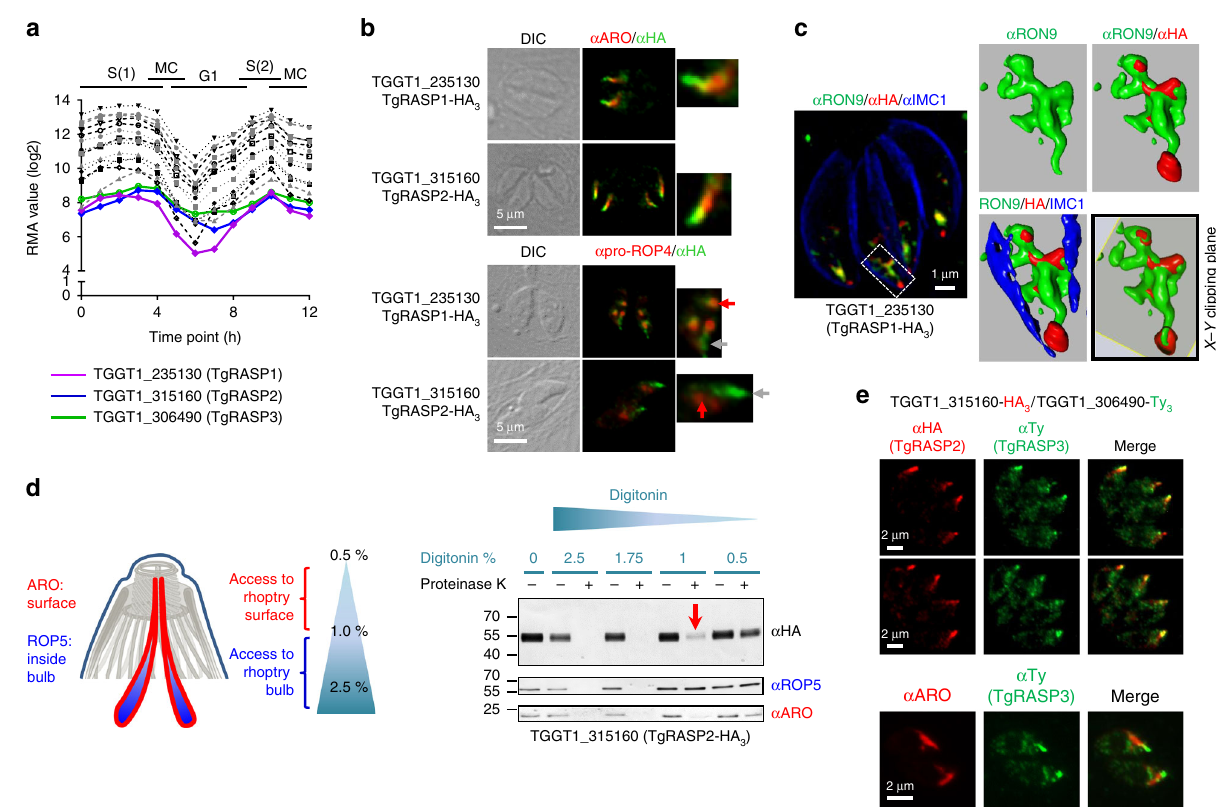
Fig. 1 A subset of novel rhoptry surface proteins de fi ne a new apical rhoptry sub-compartment. a Comparison of the expression pattern of known rhoptry proteins during the tachyzoite cell cycle in combination with the expression pro fi le of TGGT1_235130 (TgRASP1), TGGT1_315160 (TgRASP2) and TGGT149_306490 (TgRASP3). Data obtained from ToxoDB 15 . b Immuno fl uorescence assay (IFA) of HA-tagged TGGT1_235130 (TgRASP1) and TGGT1_315160 (TgRASP2) tachyzoites. Insets/higher magni fi cations: localisation of the proteins overhanging the rhoptry neck (upper panels) and the presence of TgRASP1 in pro-rhoptries (red arrows). Grey arrows indicate mature rhoptries. c Super-resolution microscopy on TgRASP1-HA 3 tachyzoites. Inset: 3D reconstruction of the apical region shows how the rhoptry neck is capped (see X-Y clipping plane). d Schematic representation of the differential permeabilization assay and localisation of ROP5 and ARO. Immunoblots of TgRASP2-HA 3 , ROP5, and ARO show that, TgRASP2 is accessible to proteinase K digestion after permeabilization with 1% digitonin (arrow) similarly to the rhoptry surface protein ARO. e Two upper panels: IFAs of TgRASP2-HA 3 and TgRASP3-Ty 3 parasites using anti-HA and anti-Ty antibodies reveal co-localisation of the two proteins. Lower panel: co-localisation of ARO and TgRASP3- Ty 3 . TgRASP3 is present at the extremity of the rhoptry, however additional staining in the cytosol is also observed for this protein. Source data are provided as a Source Data fi le